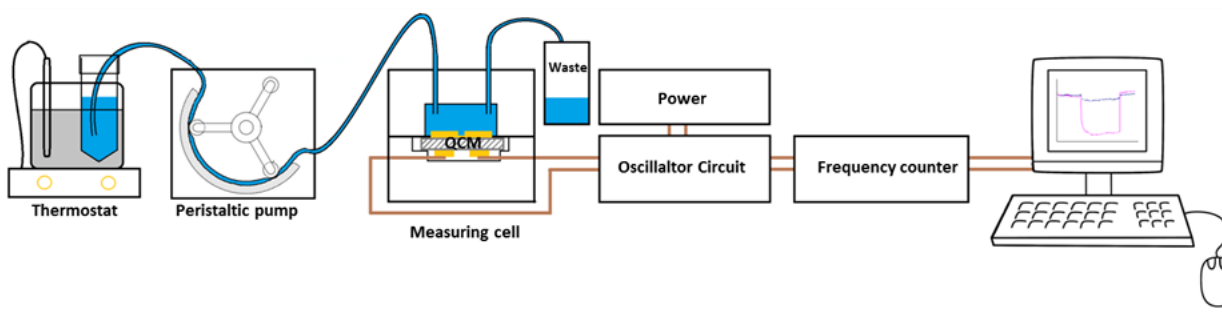
Figure 2. Measurement setup consisting of measuring cell, oscillator circuit and frequency counter. The thermostated solution was pumped through the measuring cell (0.46